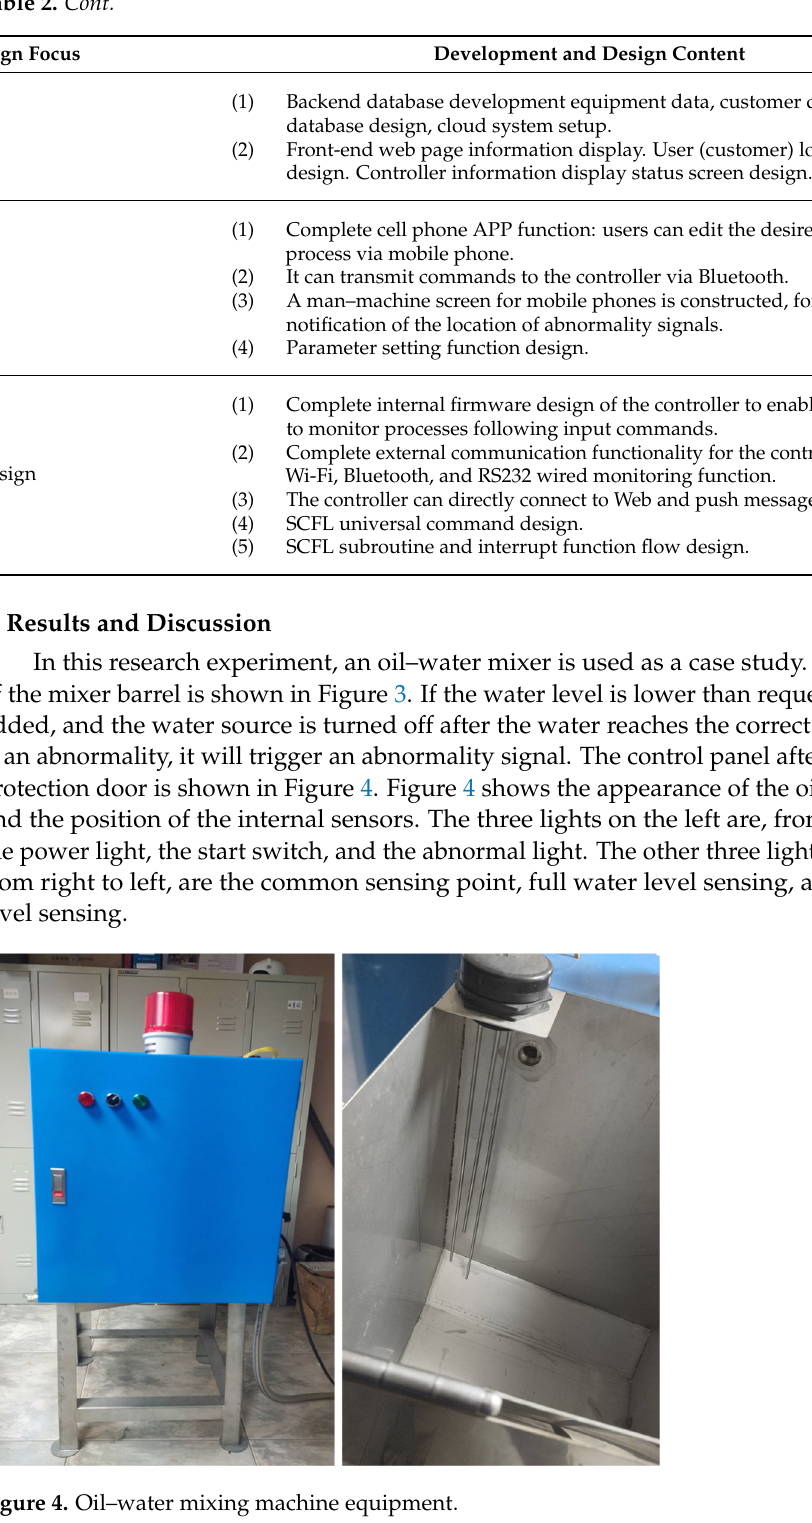
Figure 5. Oil–water mixer with the Intelligent Programmable IoT Controller. 4.1. Controller Planning For the oil-water mixer, a total of five input signals and three output signals are used in this research. The Bool and Timer registers are also used. The plan is shown Table 3. The input signals are either sensor signals or pushbuttons, with five settings from X 0 to X 4 . The output signals are mainly for the control of relays or pneumatic cylinders and are set from Y 0 to Y 2 . In addition, the input and output signals are independent and do not correspond to each other.